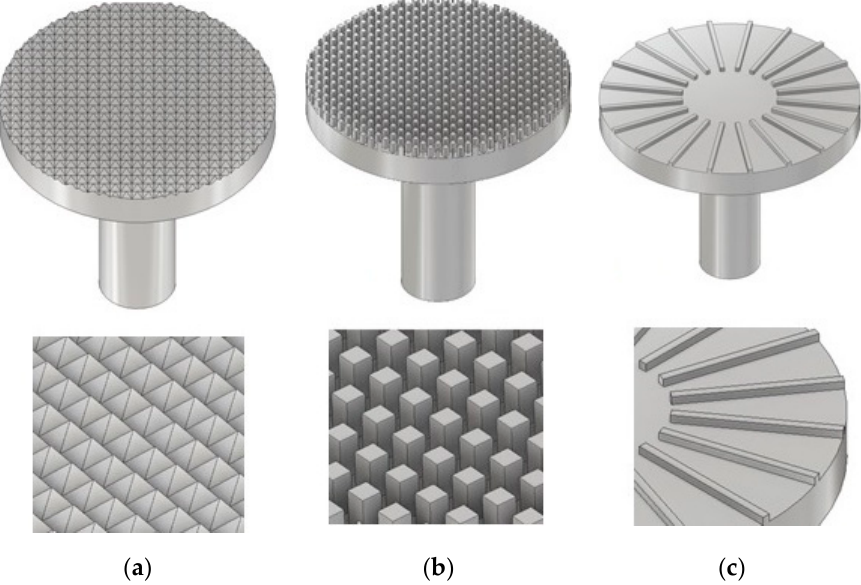
Figure 3. CAD construction of the modified parallel-plate systems with pyramidal structure ( a ), columnar structure ( b ), and longwise bars ( c ). Table 1. Geometric dimensions of the pyramidal structure, 𝑅 = 12.5 mm .